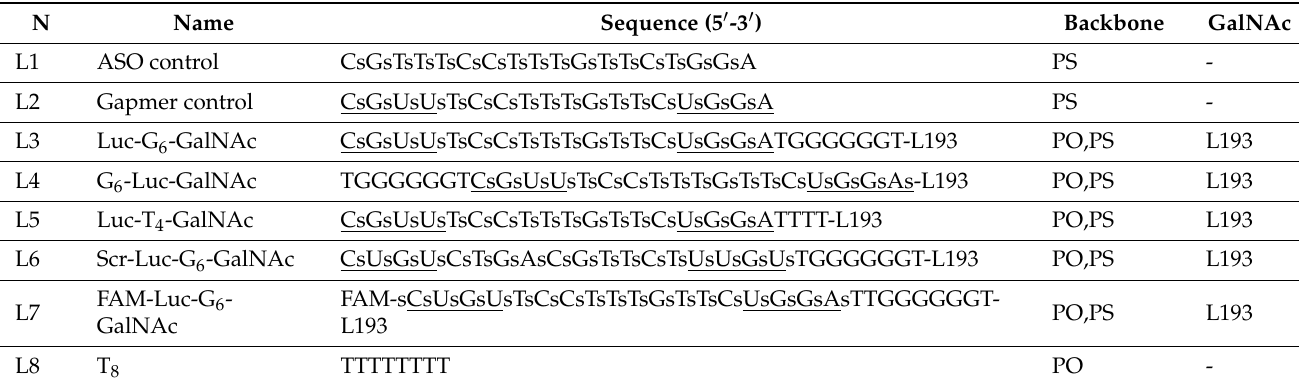
Table 2. Oligonucleotide derivatives carrying anti-luciferase